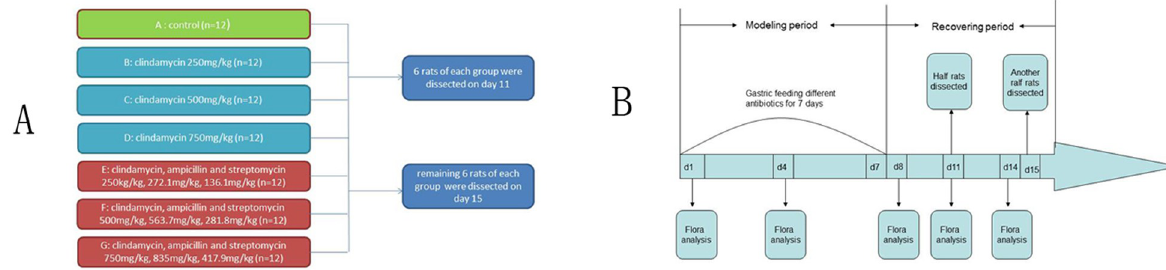
Fig 1. Study flow and method. (A) Group design of the study. (B) Experimental work flow of the study.